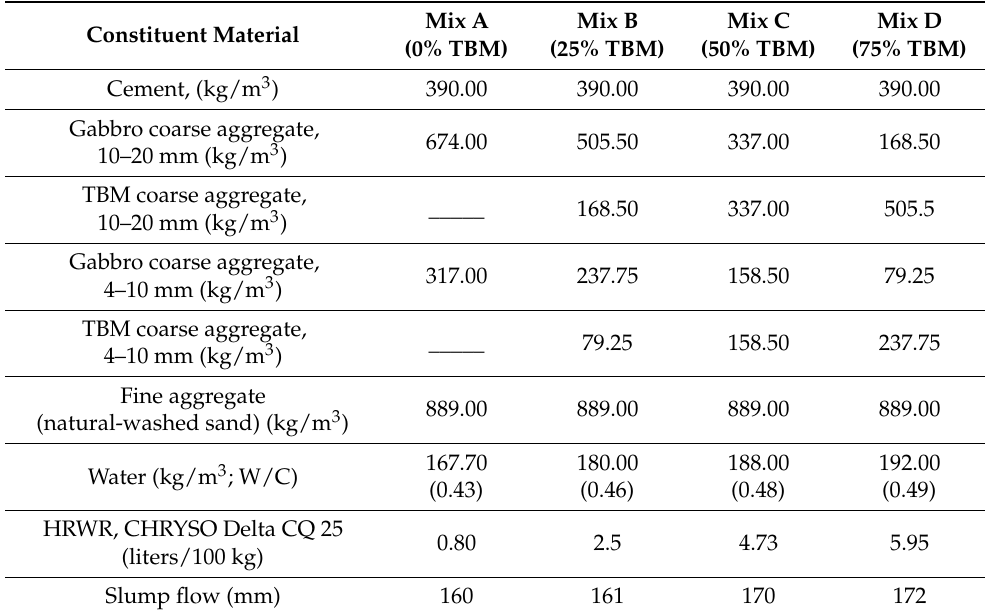
Table 3. Mix designs and the slump flow values of all